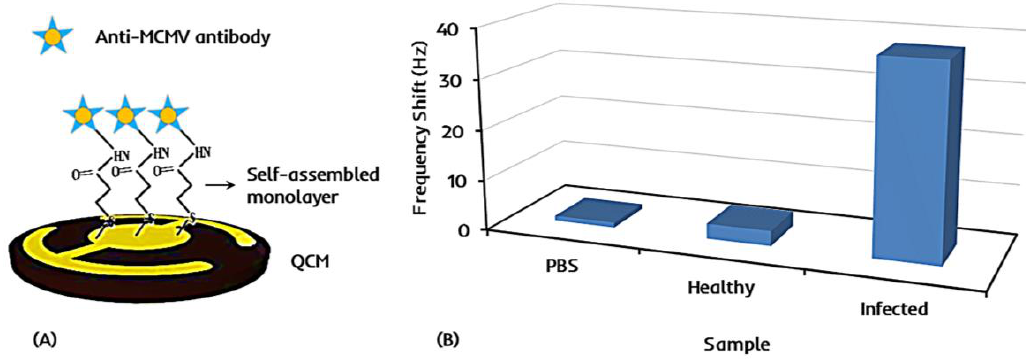
Figure 6. ( A ) A schematic diagram showing modification of the gold electrode surface of a QCM for the detection of maize chlorotic mottle virus (MCMV); ( B ) The sensor response of anti-MCMV natural antibody (NAb)-coated QCM biosensors towards phosphate-buffered saline (PBS, pH 7.4, 0.01 M) and the crude extractions from healthy and infected maize plants. Figure 6B is reproduced with permission from Huang et al. [94]. Copyright by the Royal Society of Chemistry, 2014.